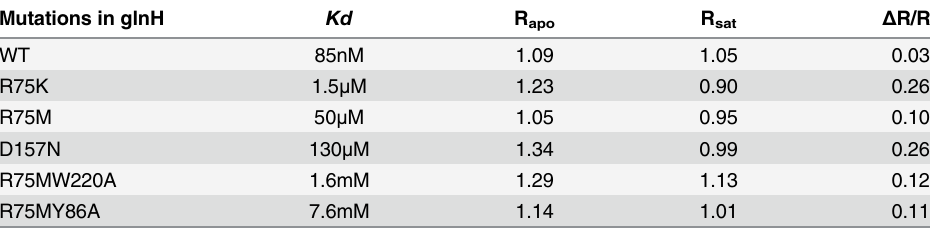
Table 1. Affinities of FLIPQ-TV3.0 point